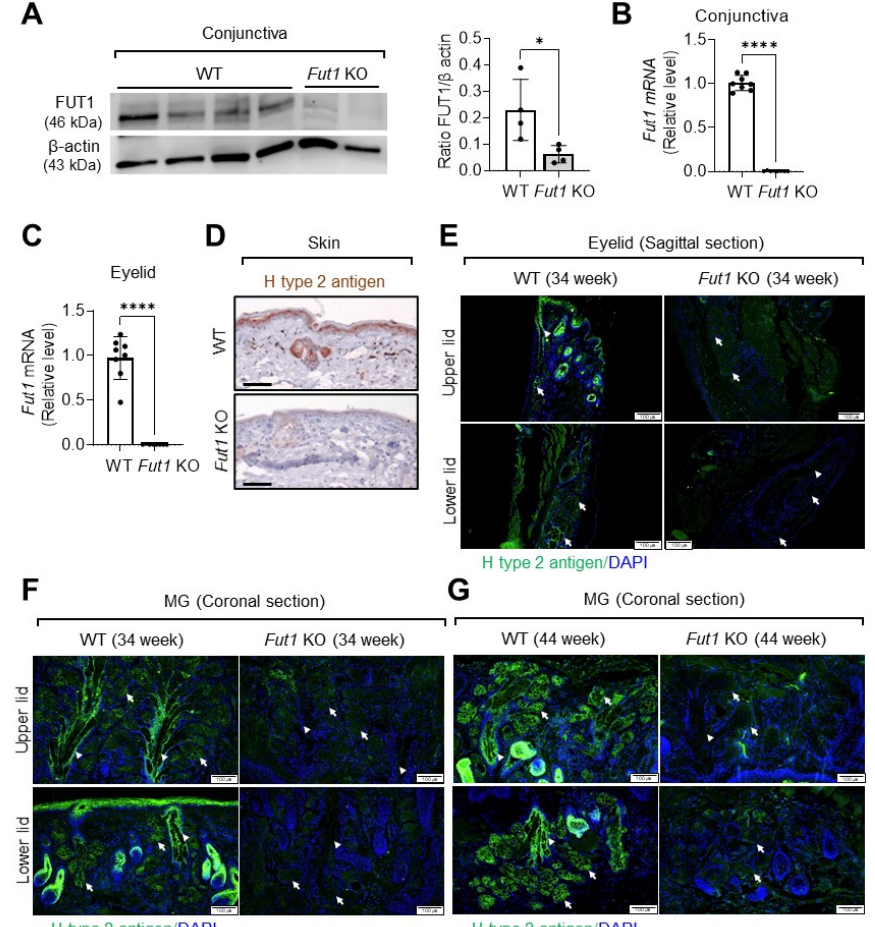
Figure 1. Loss of FUT1 and fucosylated products in the skin, conjunctiva, eyelid and MG in Fut1 KO mice vs. WT mice. ( A ) Representative Western blot image and quantitative densitometric analysis of FUT1 and β actin in the conjunctiva in WT and Fut11 KO mice. ( B , C ) Real-time RT-PCR for the Fut1 gene in the conjunctiva ( B ) and eyelid ( C ). The mRNA levels in Fut1 KO mice are presented as fold changes relative to those in WT mice. ( D ) Immunostaining of H type 2 antigen in the skin in WT and Fut1 KO mice. Scale bar: 50 μ m. ( E – G ) Immunofluorescence staining of H type 2 antigen in the eyelid ( E , sagittal section) and in MG ( F , G , coronal section) in 34- and 44-week-old WT and Fut1 KO mice. The white arrows and arrowheads indicate the acinar and ductal epithelial cells of MG, respectively. Mean values ± SD are presented, where each dot represents the data from an individual mouse. * p < 0.05, **** p < 0.0001, as analyzed by unpaired t-test. 2.2. Effects of FUT1 Deficiency on MG Development and Function with Age To investigate the effects of FUT1 on the development and function of MG, we next assessed the changes in the total and acinar areas of MGs and the levels of meibocyte differentiation and lipid synthesis in Fut1 KO mice with age, and compared them with those in WT mice. Transillumination meibography revealed that the total area of MGs was approxi- mately two times larger in the upper eyelids than in the lower eyelids in 8-week, 34-week and 44-week-old Fut1 KO mice, and that the MG areas in both upper and lower eyelids did not change with age (Figure 2A,B). Remarkably, the total MG area in upper and lower eyelids was significantly smaller in Fut1 KO mice, compared to WT controls, in all age groups (Figure 2A,B).